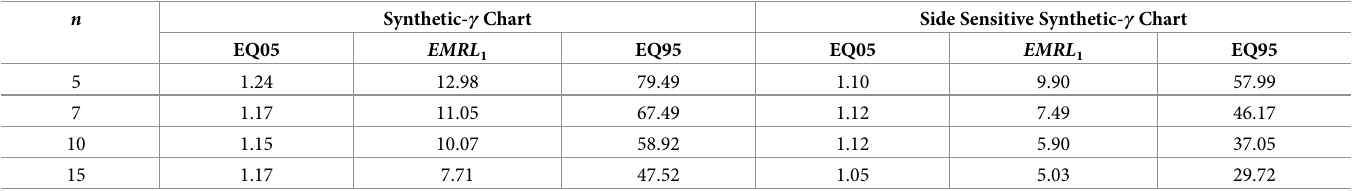
Table 10. Comparison of the EQ05, EMRL 1 and EQ95 of the EMRL -based synthetic- γ chart (without side sensitivity) and side sensitive synthetic- γ chart for γ 0 = 0.05, n 2 {5,7,10,15} and ( τ min , τ max ) = (1,2]. n Synthetic- γ Chart Side Sensitive Synthetic- γ